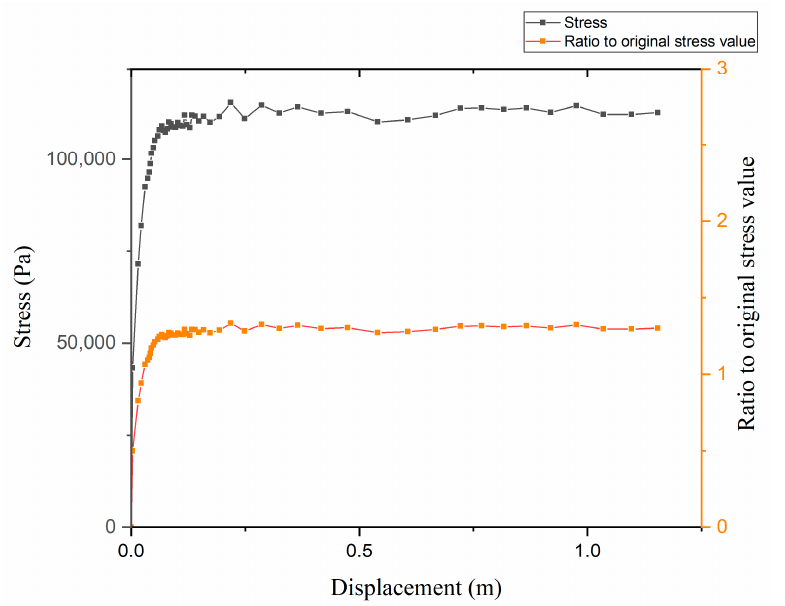
Figure 23. Stress variation after shallow soil landslide. The black line corresponds to the vertical axis of stress on the left, and the orange line corresponds to the vertical axis of the ratio to original stress value on the right.